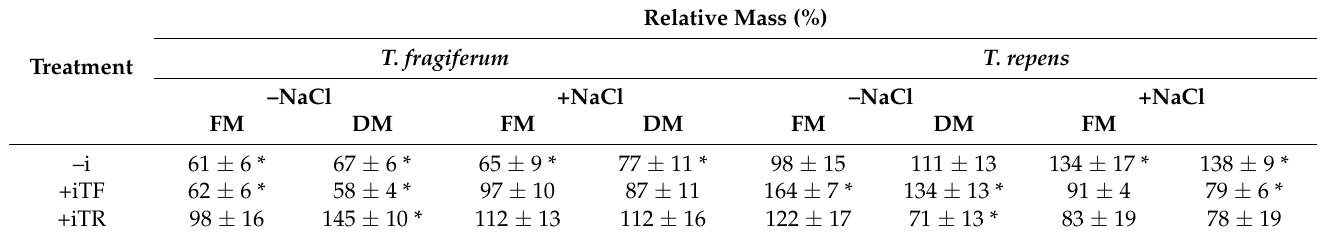
Table 8. Relative effect of species coexistence (values from the respective treatment combinations in single species conditions were indicated as 100%) on total fresh and dry mass of shoots of the two Trifolium